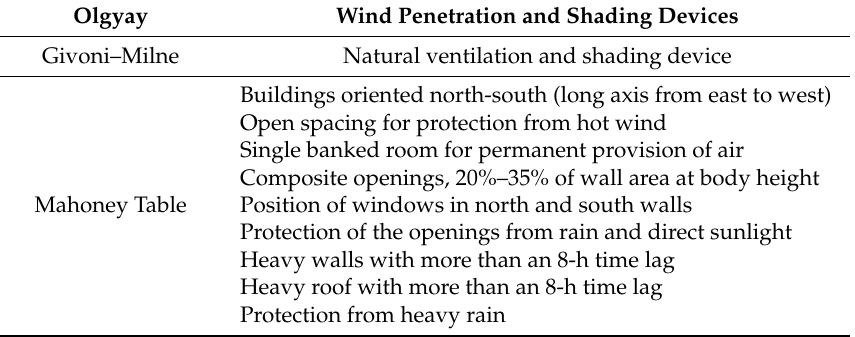
Table 14. Summary of design